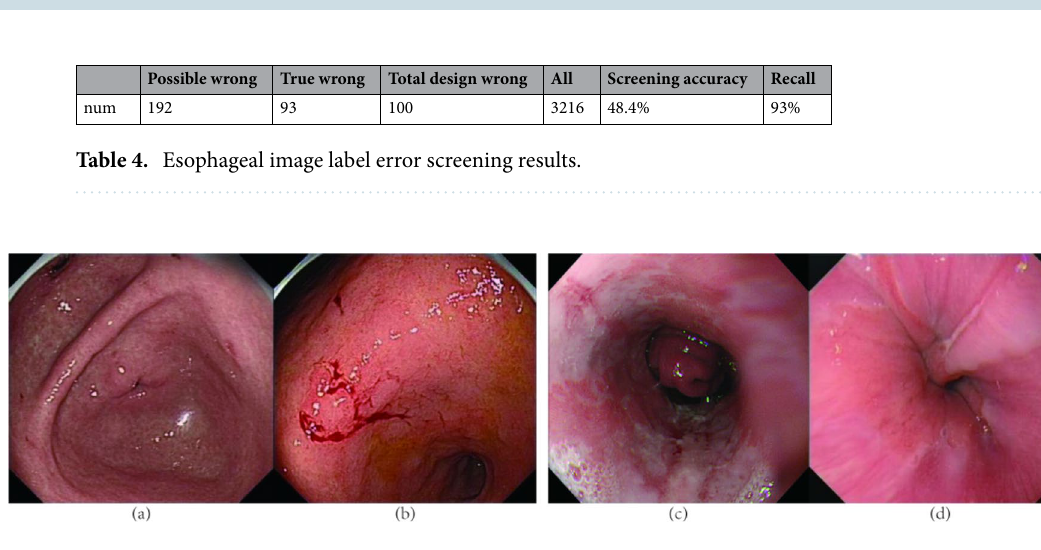
Figure 3. Error images added, wherein ( a , b ) are gastric disease images, and ( c , d ) are other diseases of endoscopy.